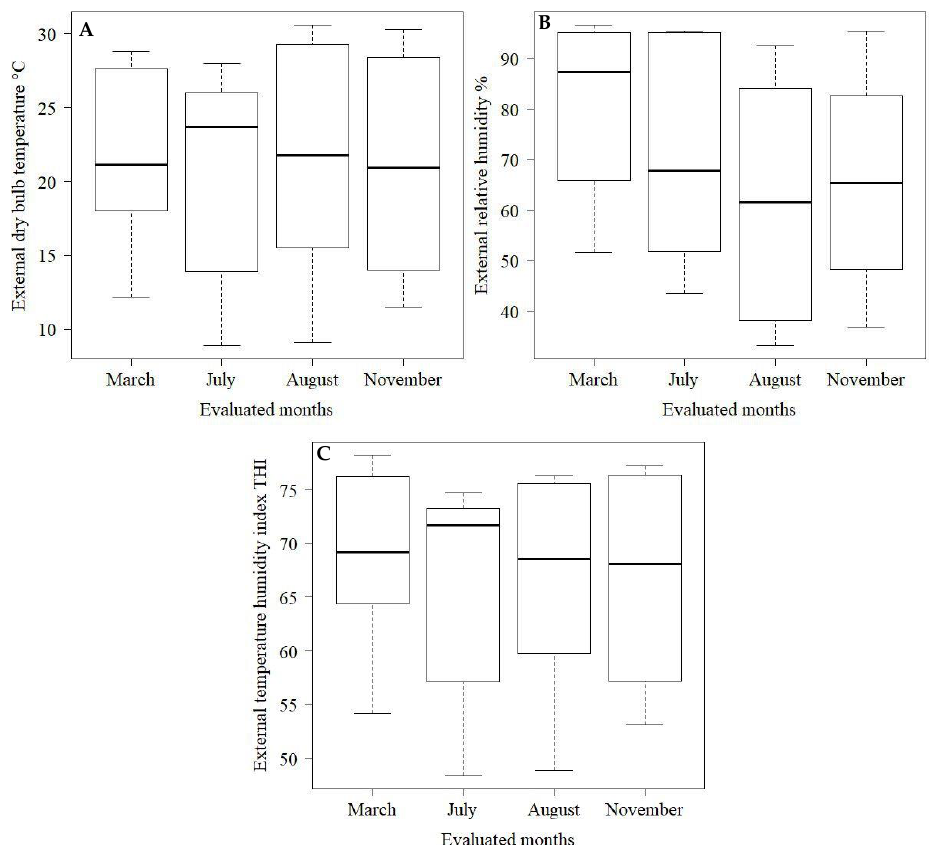
Figure 4. Box-plot of external dry bulb temperature ( A ), external relative humidity ( B ), and external temperature humidity index ( C ) during the experimental period.